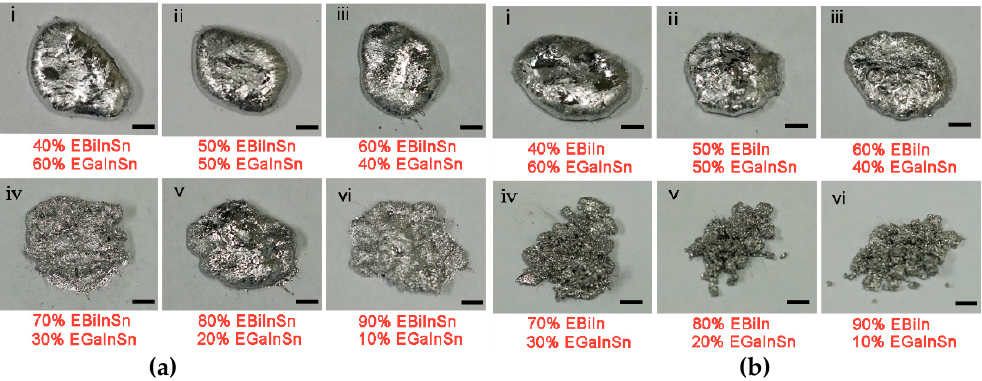
Figure 2. ( a ) Image of different mass ratios of EBiInSn in mixture. ( b ) Image of different mass ratios of EBiIn in mixture. With increased mass ratio of bismuth-based alloy, the mixture changes from a liquid to a powdery solid. Scale bars: 1 mm (the experimental mixing videos (S1 and S2) are included in the Supplementary Materials).